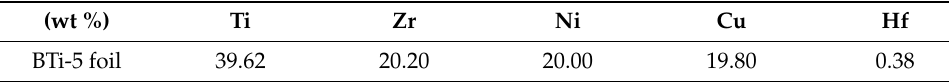
Figure 2. Three–dimensional noncontact profilometry images of the two planar substrates: ( a ) H- C22 and ( b ) alumina.